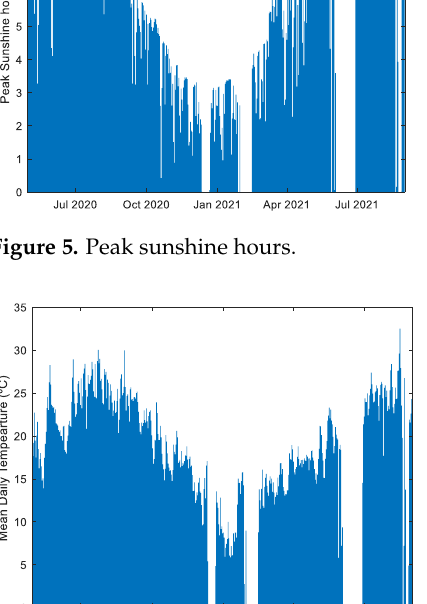
Figure 6. Mean daily temperature.